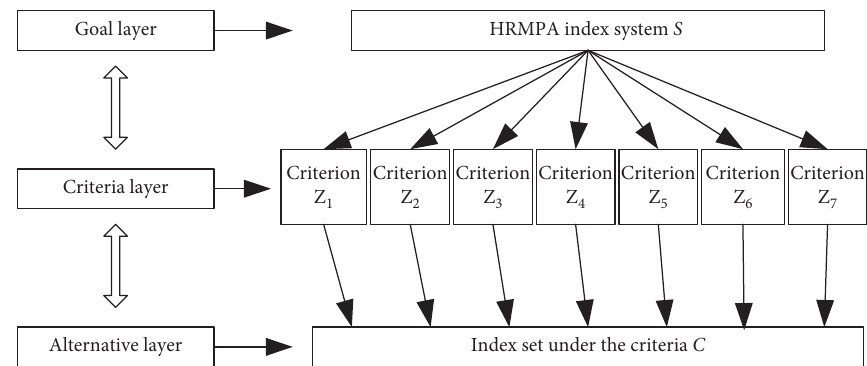
Figure 1: Hierarchical structure of the corporate HRMPA index system.